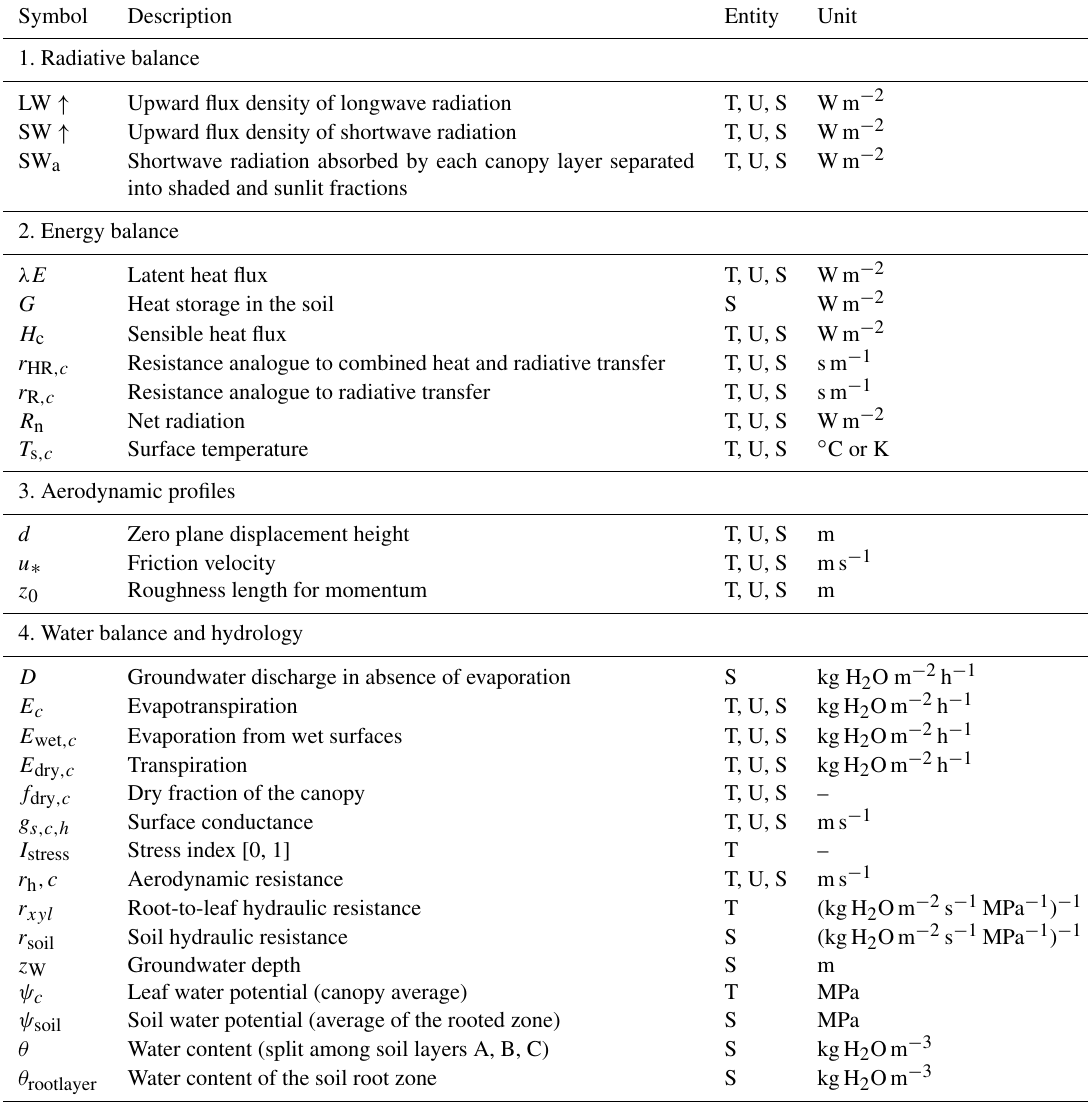
Table A1. List of the prognostic variables of the GO+ v3.0 model. Table is split among the main processes. The entity subscripts T, U and S stand for tree canopy, understorey canopy and soil, respectively. The subscript “t” is for individual trees. Symbol Description Entity